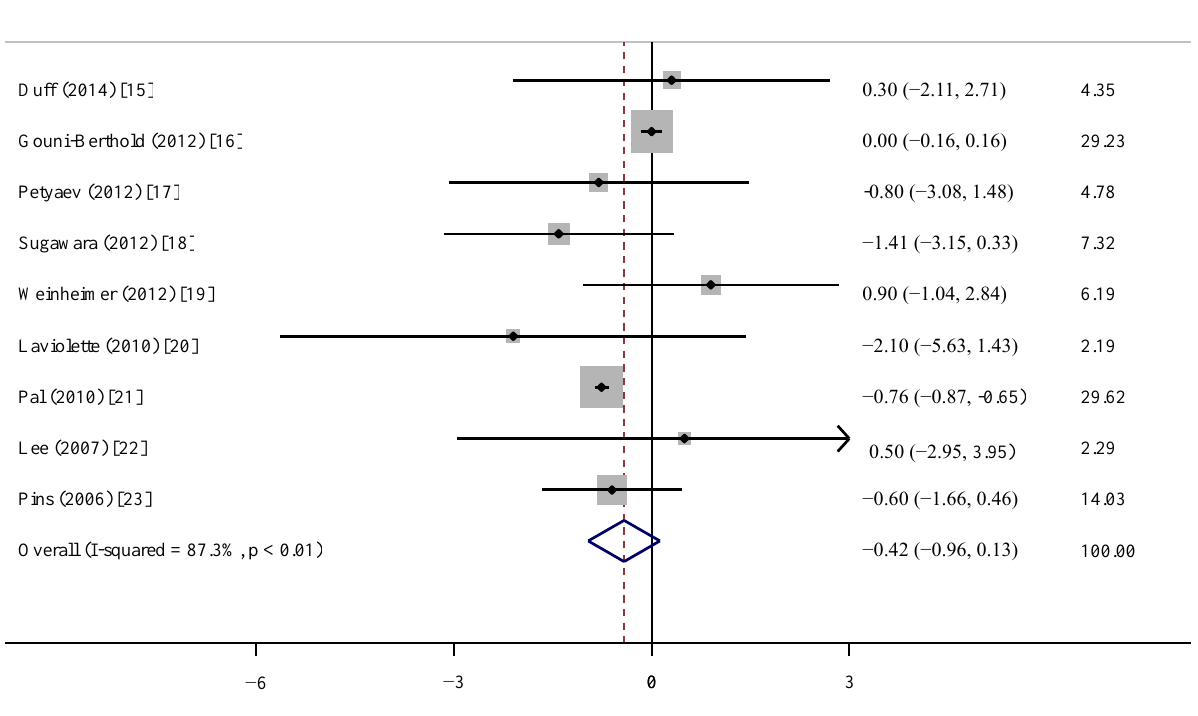
Figure 2. Meta-analysis of the effect of whey supplementation on circulating CRP level as compared with the control. WMD, weighted mean